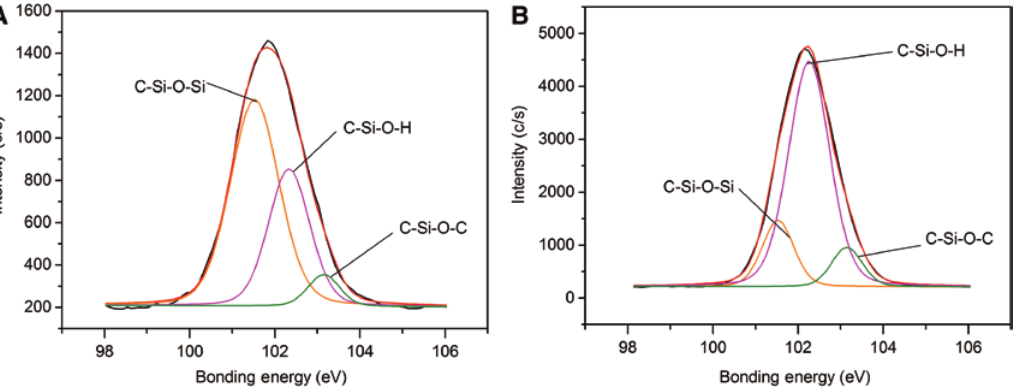
Figure 6: Si 2p XPS spectrum of diamond (A) KH550 modified diamond in aqueous alcohol, (B) KH550 modified diamond in toluene.